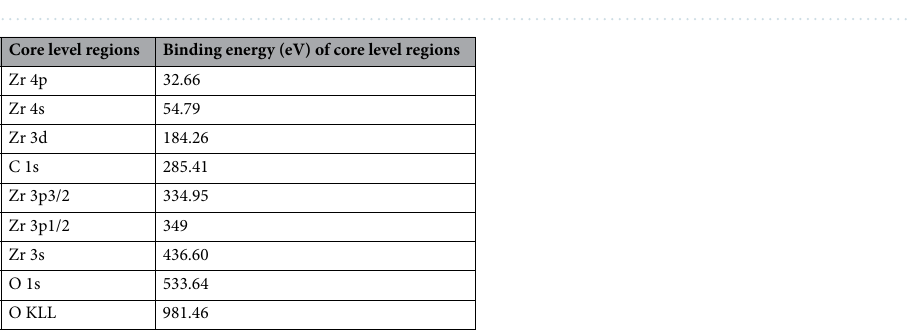
Figure 7. XPS spectra: ( a ) survey spectra of ZrO 2 samples, ( b ) high resolution spectrum of O 1s ( c ) high resolution spectrum of Zr 3d of virgin and high fluence (2E14 ions/cm 2 ) irradiated ZrO 2 thin films, ( d ) Zr 3d determining the peak shifting and spin- orbit splitting (δ 3d ) ( e ) shifting of O 1s core level by 1.4 eV towards higher binding energy and curve fitting of O 1score level of ( f ) virgin ( g ) irradiated sample at higher fluence 2 × 10 14 ions/cm 2 .